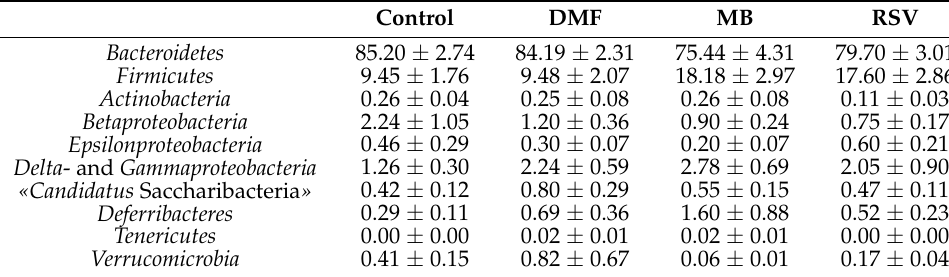
Figure 8. Level of Firmicutes phylum level in the gut microbiome. The results expressed as means ± SEM. Control n = 8, DMF = 8, MB = 6, RSV = 6. Table 6. Phyla of bacteria in gut microbiome. Results of PCR analysis.